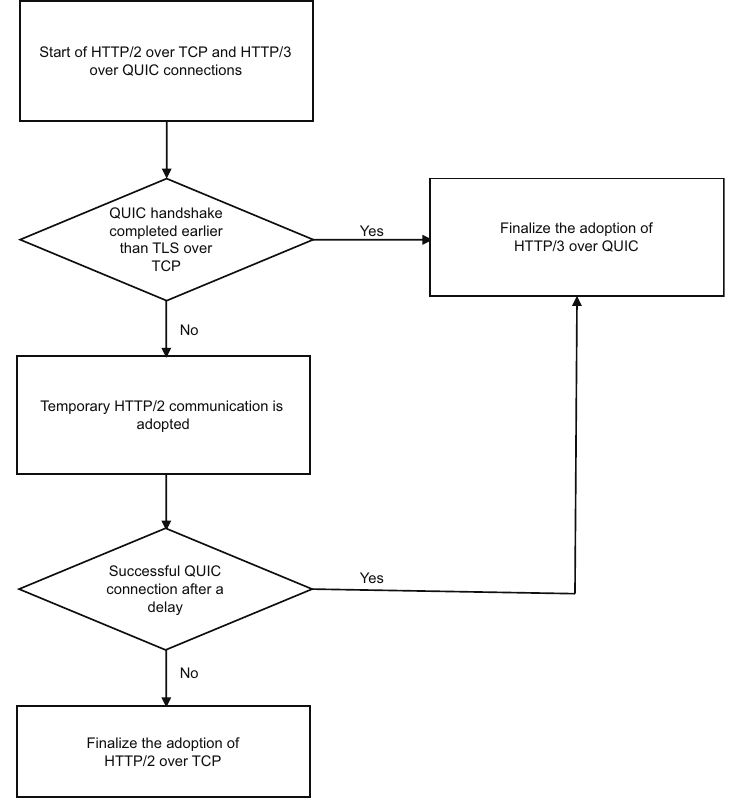
Figure 3. Flowchart of proposed